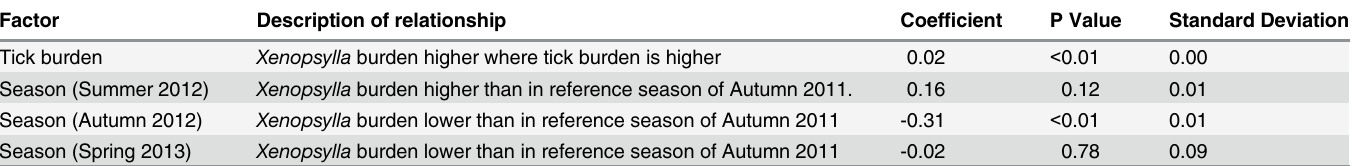
Table 5. Description of terms in parsimonious model of Xenopsylla